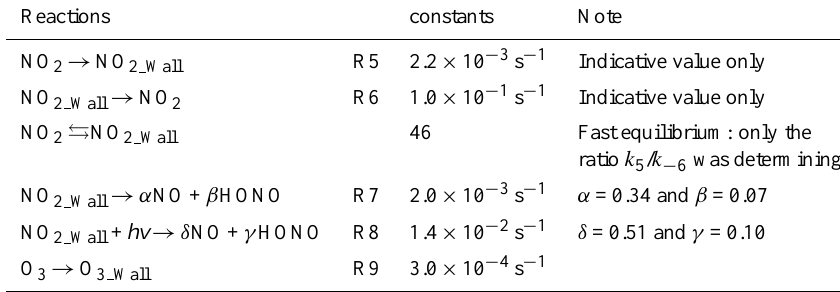
Table 4. Chemical reactions introduced in the numeric model for simulating the experimental observations.